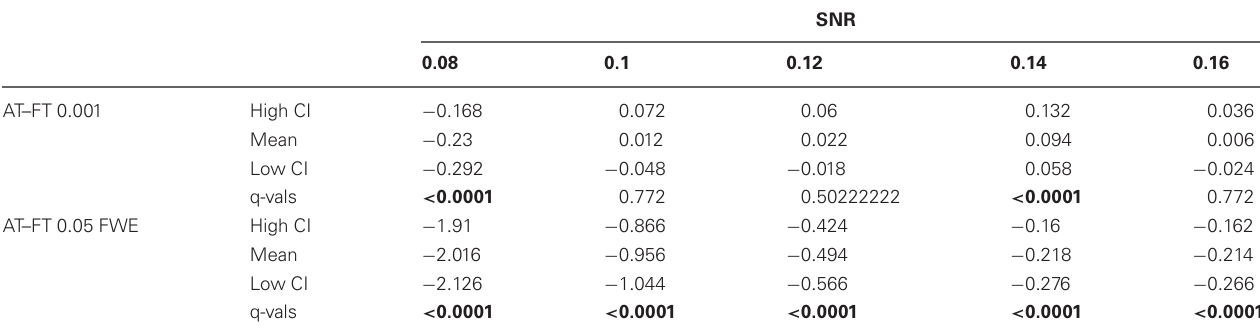
Table 2 | Statistical analysis of the pair-wise difference (AT-FT) comparison of the total number of errors (false positive + false